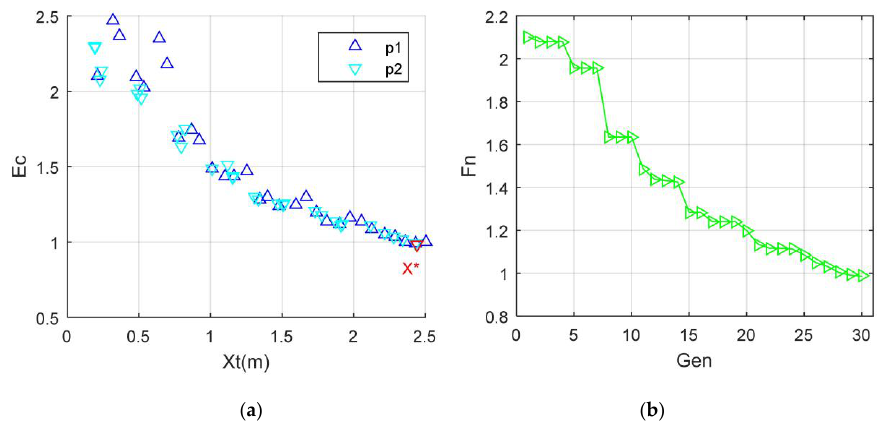
Figure 13. Aero-stealth optimization: C qw1 = 0.7 ; C qw2 = 0.3; α m = 50 ° ; F rh = 6 GHz; β = 0 ° ; X m = 2.5 m; V ∞ = 125.8 m/s; ( a ) Comprehensive evaluation index; ( b ) F n results.